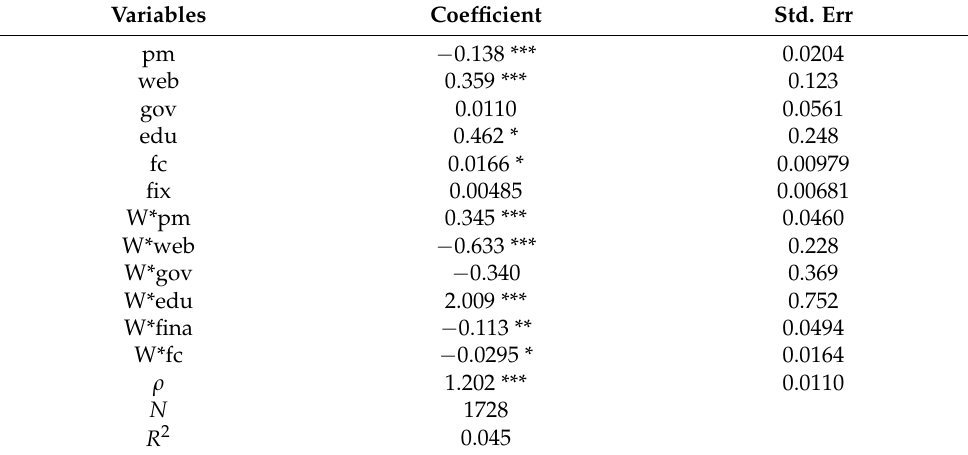
Table 4. Result of spatial Durbin